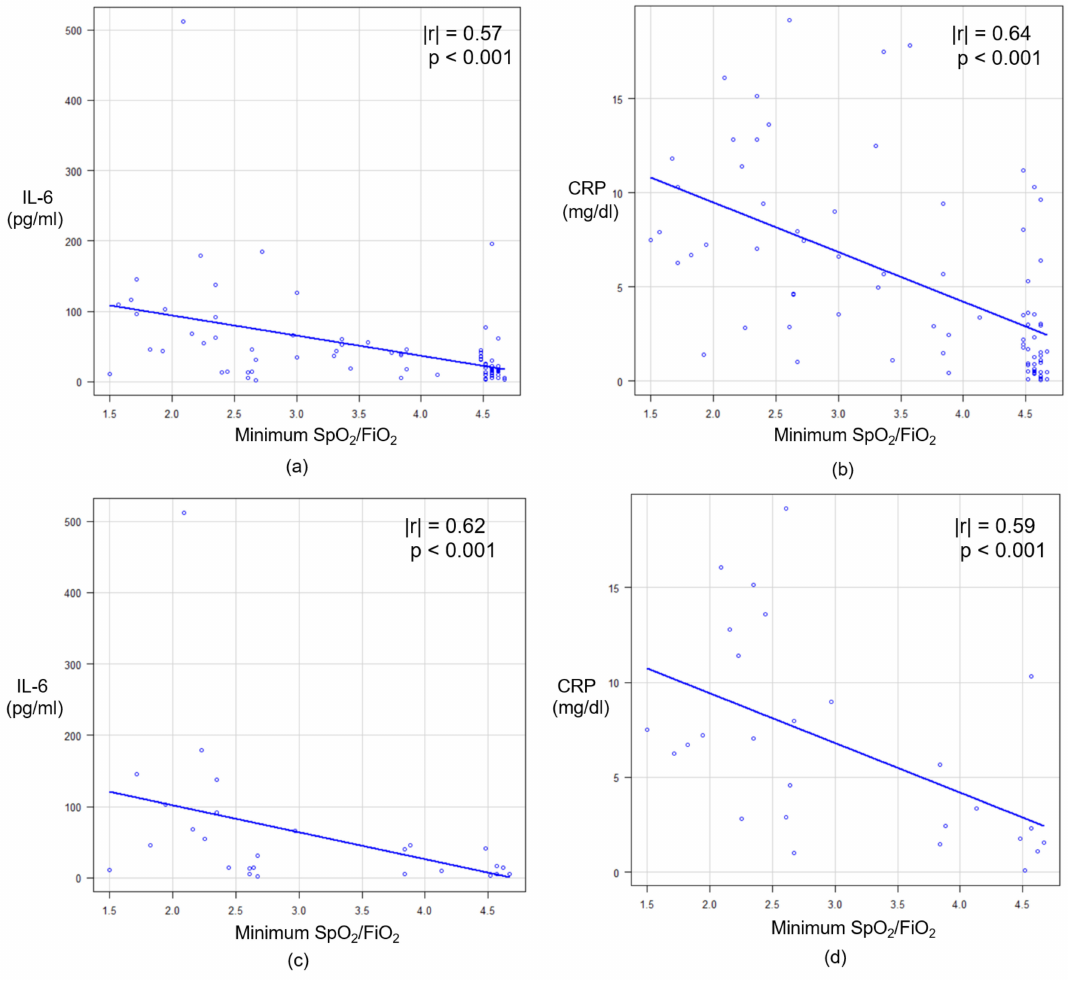
Figure 2. The correlation between minimum SpO 2 /FiO 2 ratio and each blood marker: ( a ) IL-6 and ( b ) CRP among all patients; ( c ) IL-6 and ( d ) CRP in the preceding dexamethasone group. SpO 2 , percutaneous oxygen saturation; FiO 2 , fraction of inspired oxygen; IL-6, interleukin-6; CRP, C-reactive